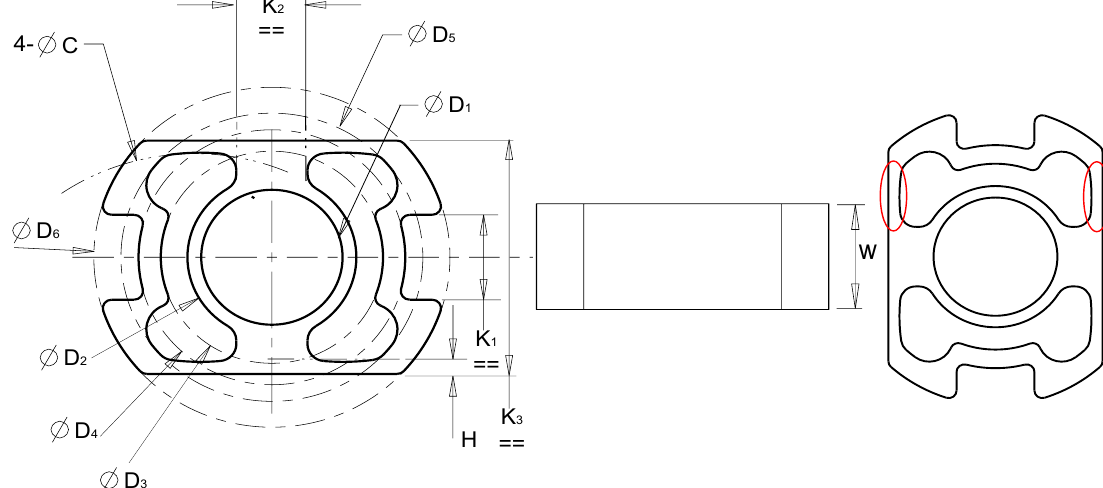
Figure 3. A drawing of easily customizable and compact strain gauge based square-cut joint torque sensor; ( left ) Computer-Aided Design (CAD) drawing; ( center ) side view of sensor; ( right ) strain gauges’ positions.